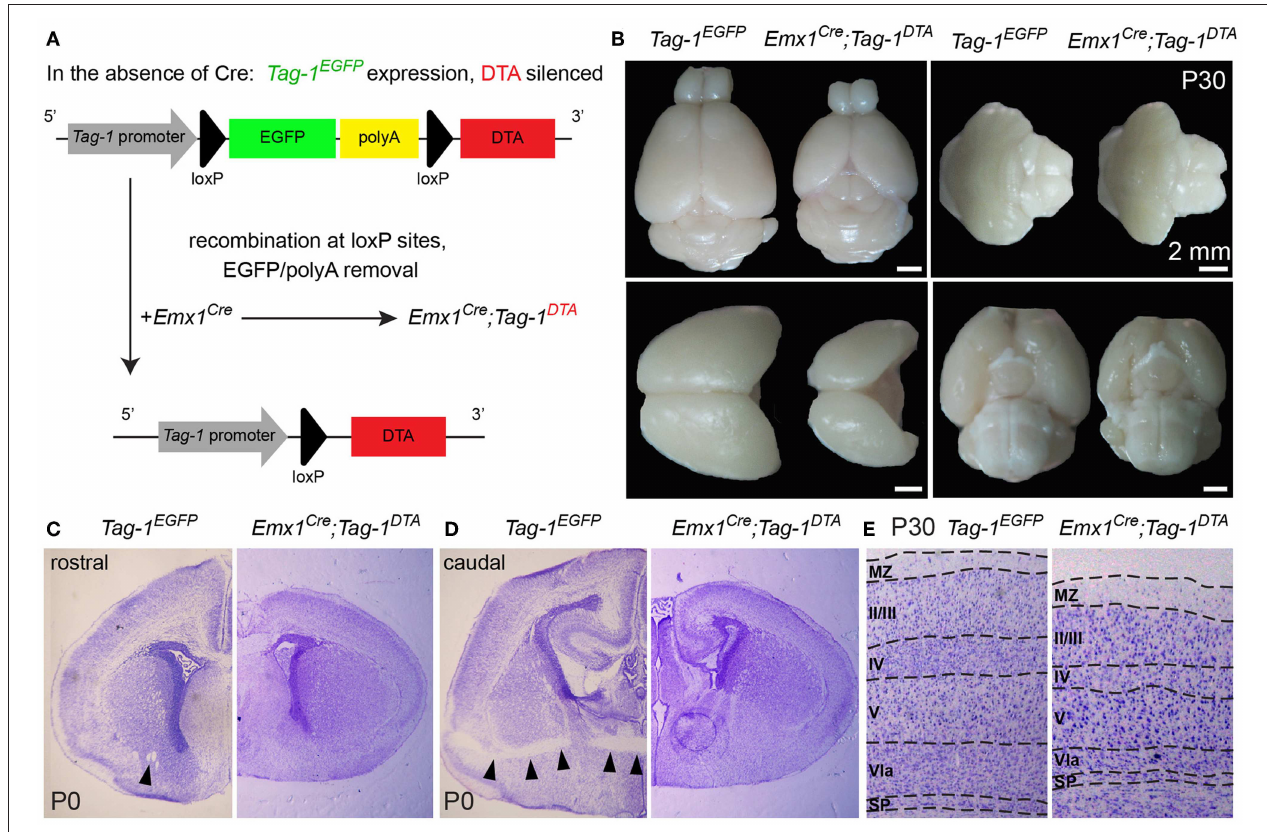
FIGURE 5 | Macroscopic cortical defects in postnatal Emx1 Cre ;Tag-1 DTA mice. (A) Schematic showing the Cre-mediated recombination of the Tag-1 loxP − EGFP − loxP − DTA locus and the expression of DTA in the cortex, with simultaneous removal of EGFP but no effect on Tag-1 expression. (B) Macroscopical examination of 1-month-old brain of Tag-1 EGFP and Emx1 Cre ;Tag-1 DTA mice, showing the decrease in size of the neocortex, while the cerebellum, pons and hypothalamus remain unaffected. (C,D) Cresyl violet morphological stain at a rostral (C) and caudal (D) level of the forebrain in Tag-1 EGFP and Emx1 Cre ;Tag-1 DTA mice. Note the absence of the anterior commissure in Emx1 Cre ;Tag-1 DTA mice, which is shown by black arrowheads in the control. No differences were observed in the thalamus or subpallium. (E) Cresyl violet morphological stain of 1-month-old brain show decrease in cortical thickness in Emx1 Cre ;Tag-1 DTA . MZ, marginal zone; SP,